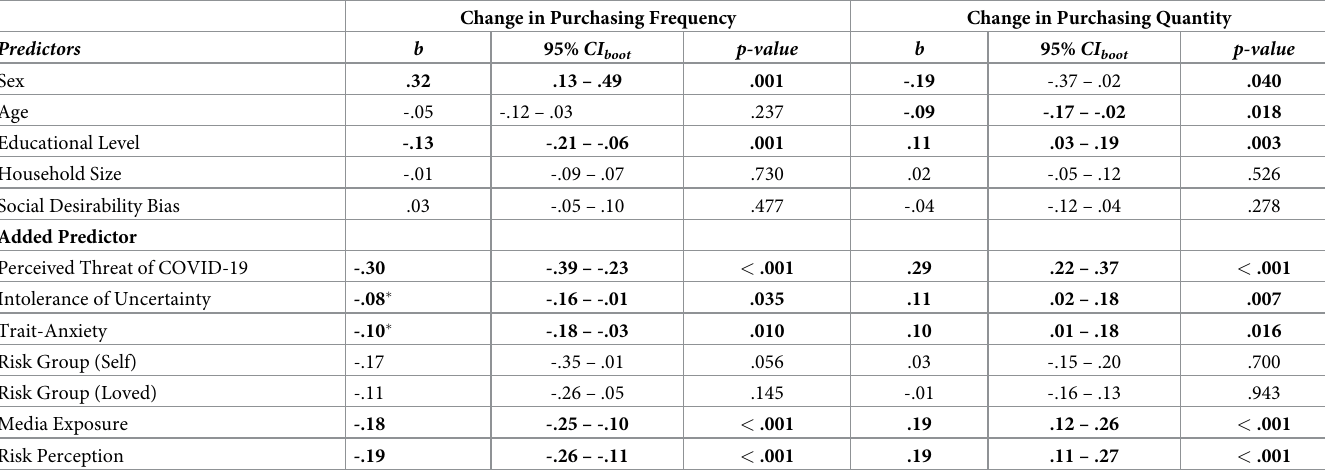
Table 2. Prediction of change in purchasing behavior